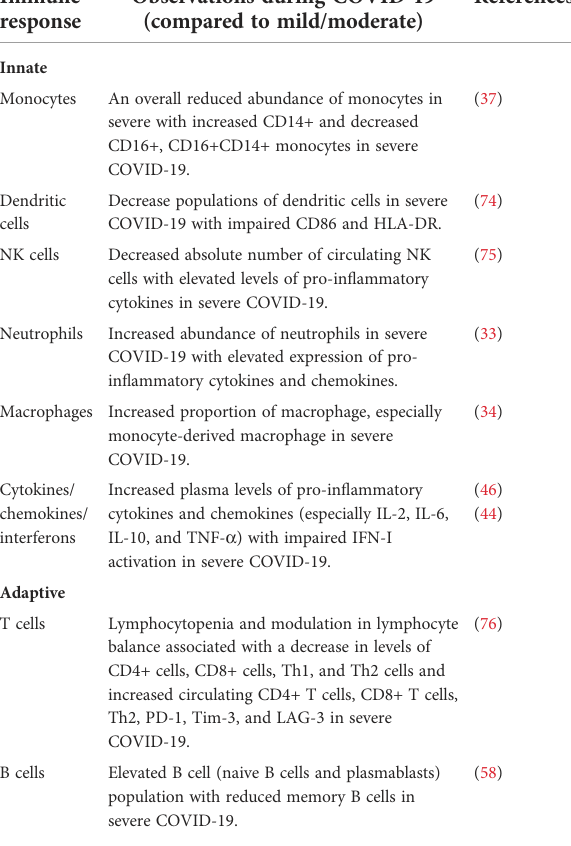
TABLE 2 Major impact on the innate and adaptive immune response during COVID-19